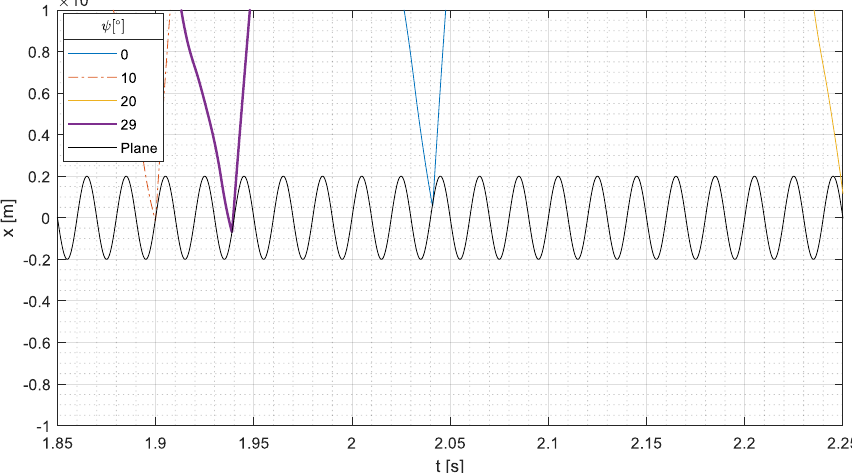
Figure 8. Numerical results, displacement of the cylindrical part along the track, impact with large relative velocity at t = 2.04, ψ = 0 ◦ , θ = 3 ◦ , f v = 0.005, µ c = 0.3, µ s = 0.6.